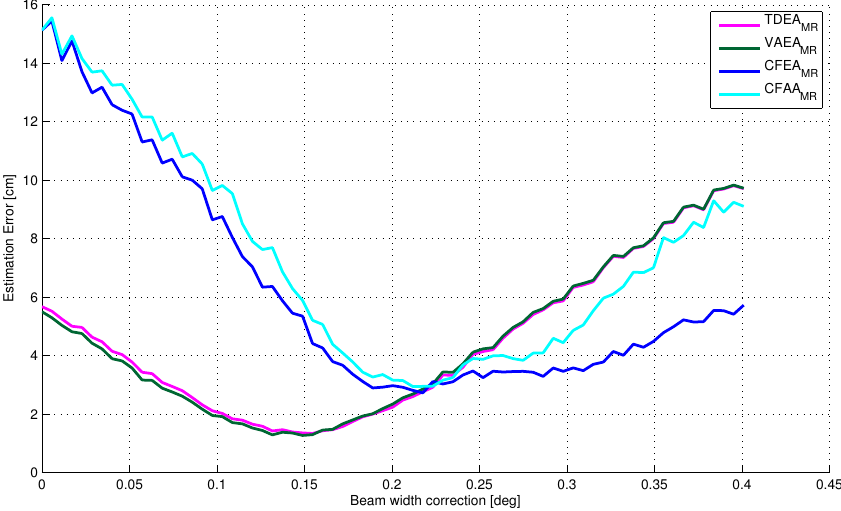
Figure 5. Absolute estimation error for varying beam width correction angle α